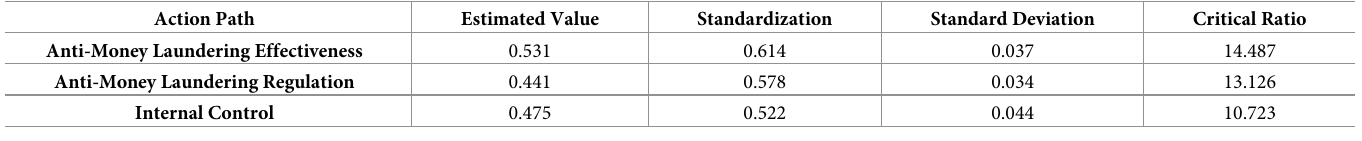
Table 6. Parameter estimation table for the modified conceptual model of influencing factors on the effectiveness of anti-money laundering regulation. Action